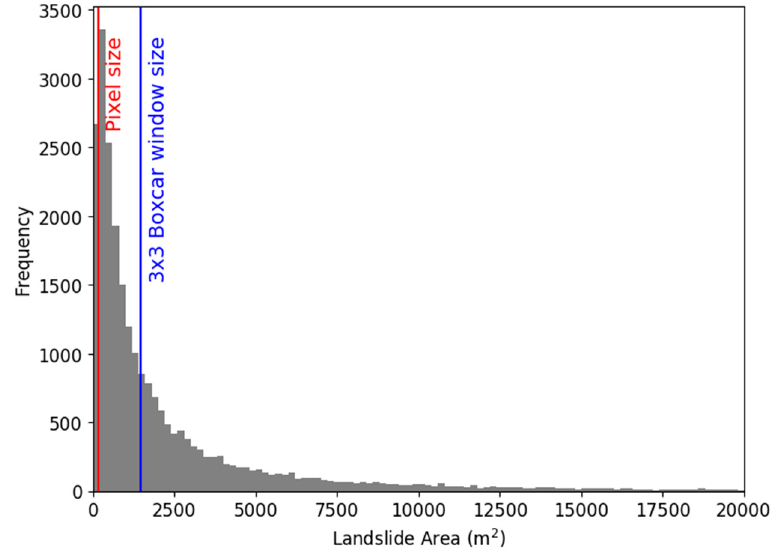
Figure 11. Histogram of landslide areas derived from the inventory of [2]. Landslides over 20,000 m 2 in area are omitted for clarity. The sizes of an individual pixel (red) and of the window used in calculation of the boxcar coherence (blue) are marked.